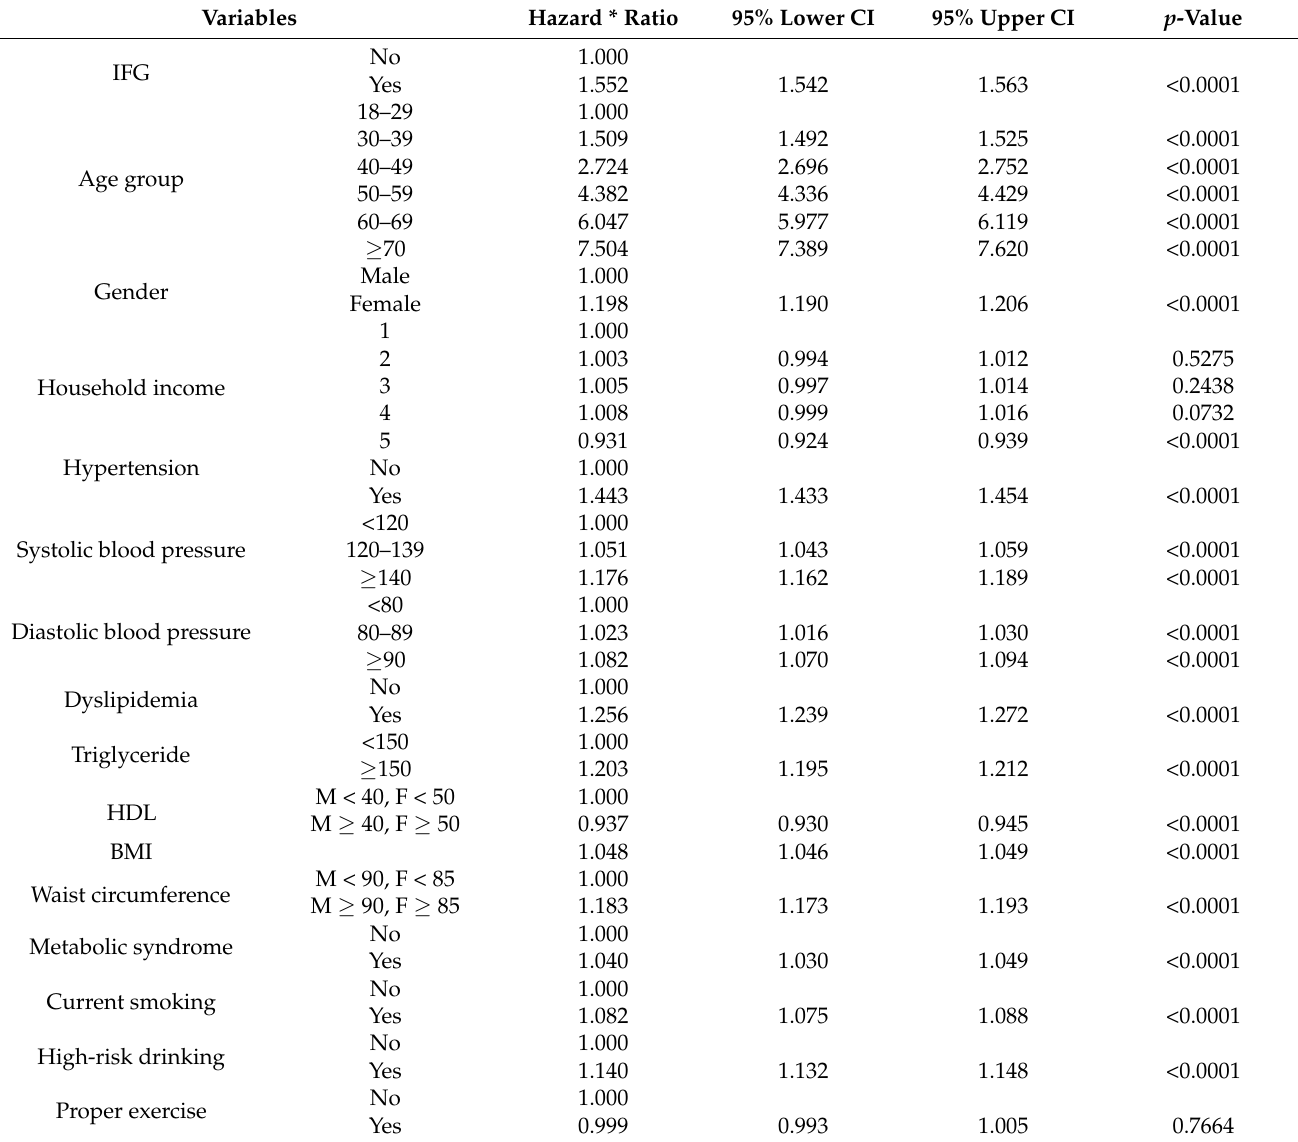
Table 4. Risk factors for the progression from non-diabetes to diabetes.